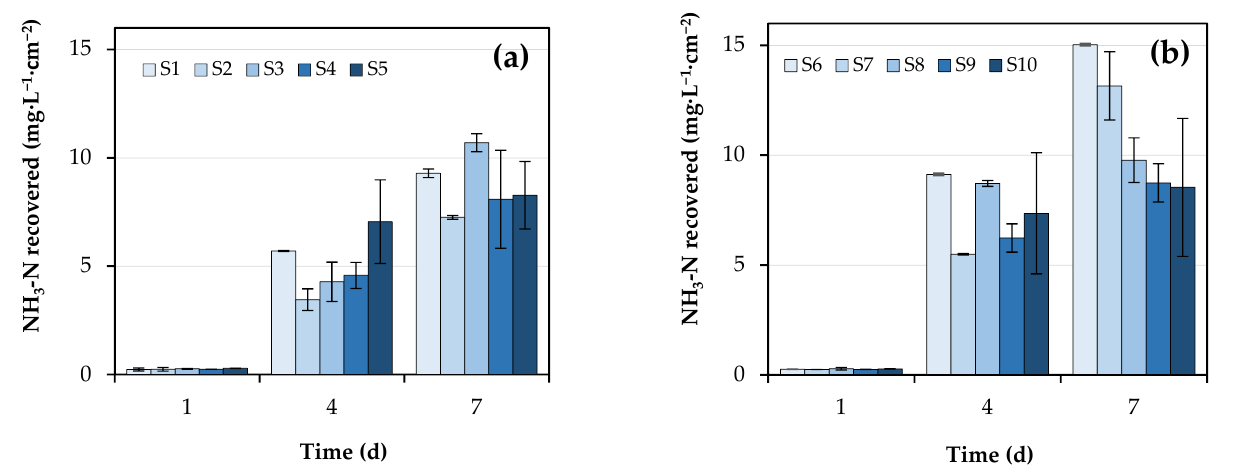
Figure 1. Evolution of NH 3 -N concentration in the acid capture solution per membrane surface area in ( a ) S1–S5 systems without sludge aeration and agitation; and ( b ) S6–S10 systems with slurry agitation and aeration. The meaning of the abbreviations is presented in Section 2.2.